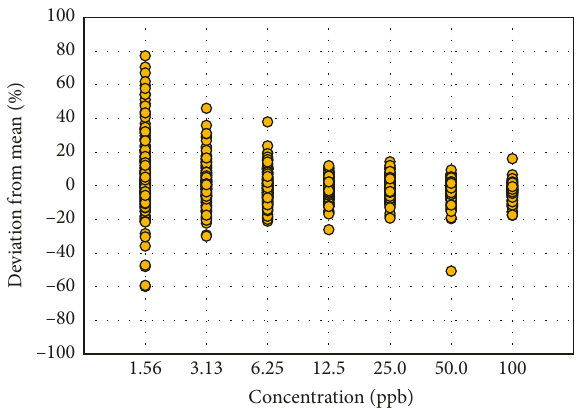
Figure 1: Deviation of ion ratios from the overall mean across different concentrations of 23 PPCPs without tetracyclines and quinolones.